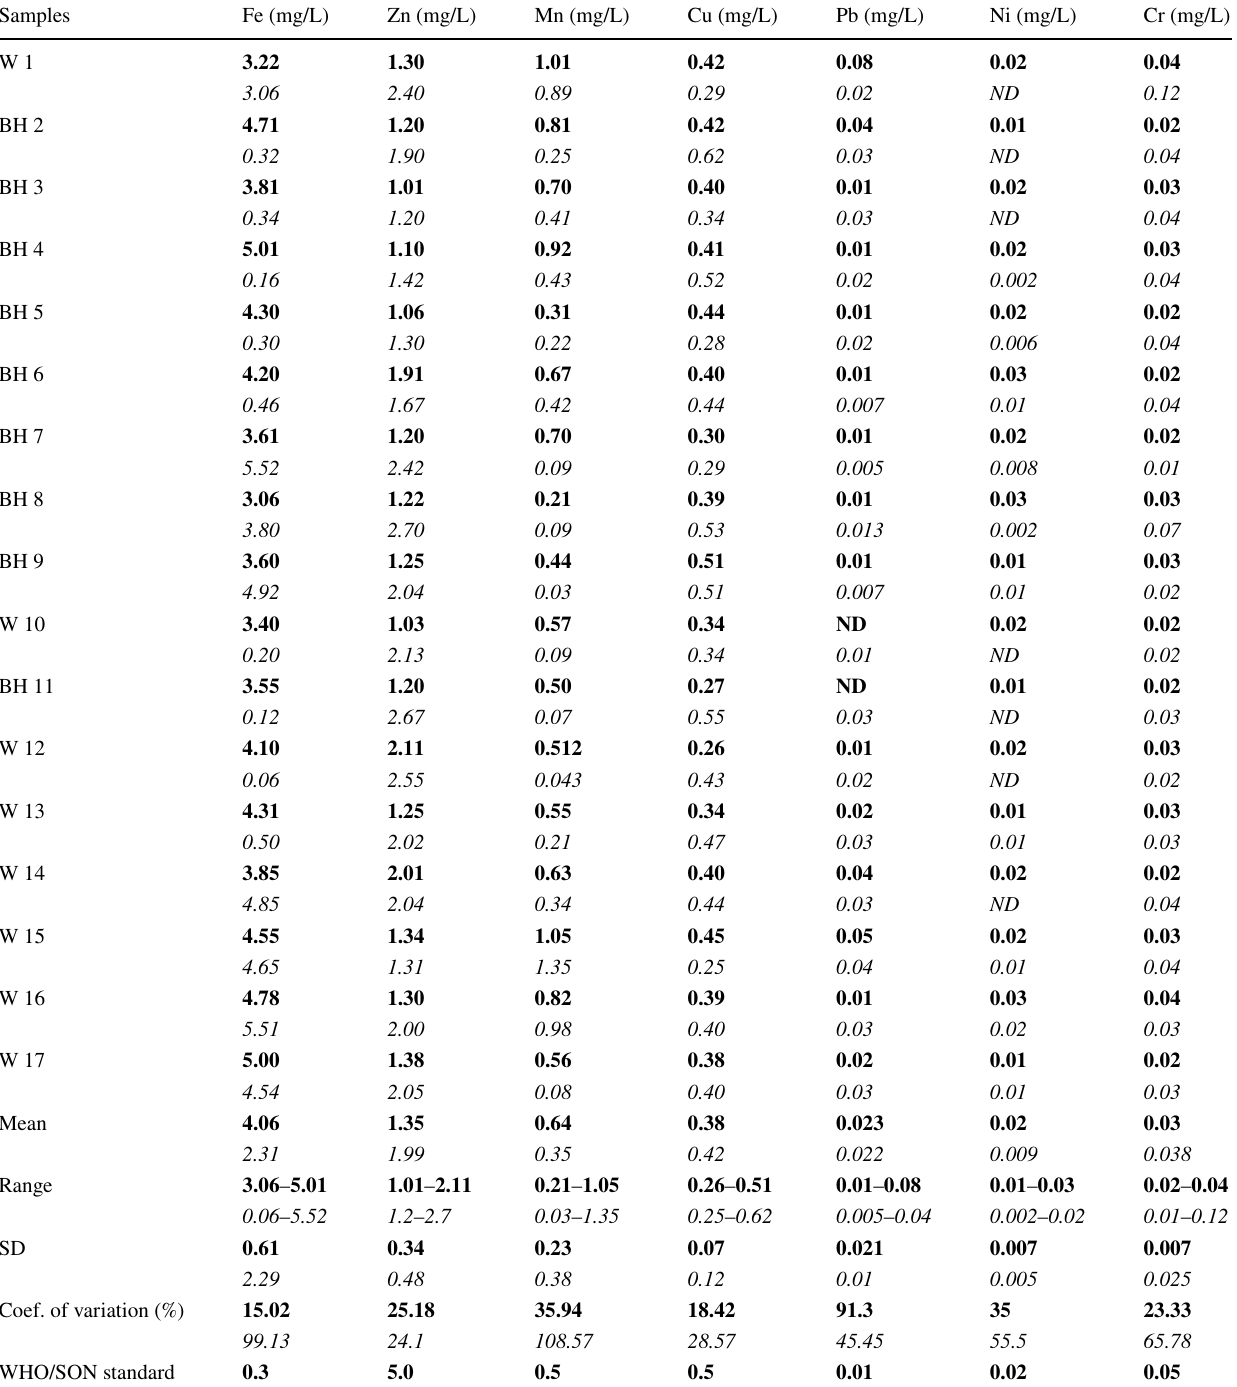
Table 3 Seasonal paired-sample statistics of heavy metal contents of water sample obtained around the Olusosun